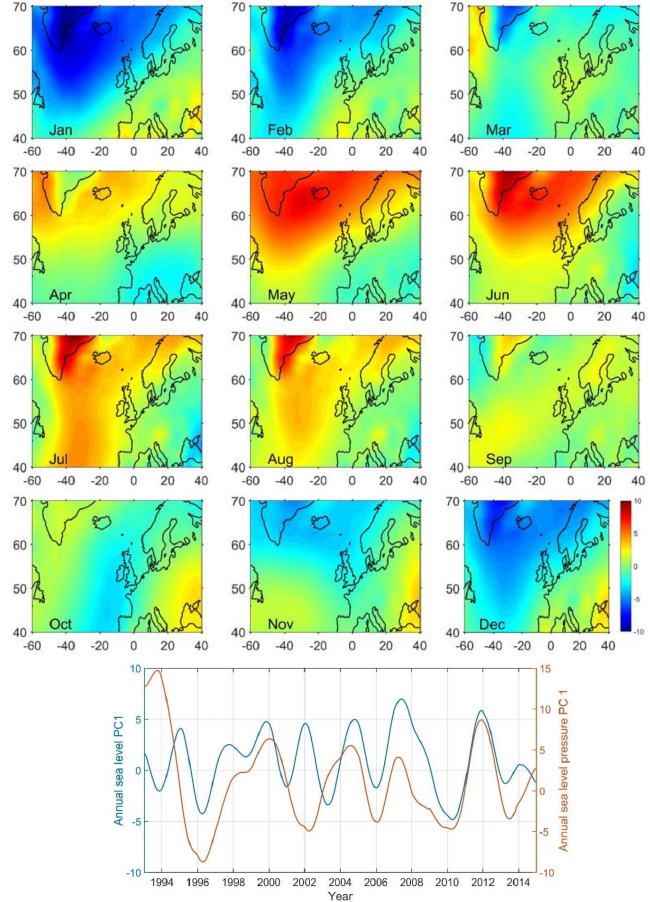
Figure 9. Similar to Figure 4 but for NCEP/NCAR Sea Level Pressure: monthly time-dependent LVs (hpa) and PC time series (computed over the region in Figure 1, dimensionless). The PC time series of annual sea level is